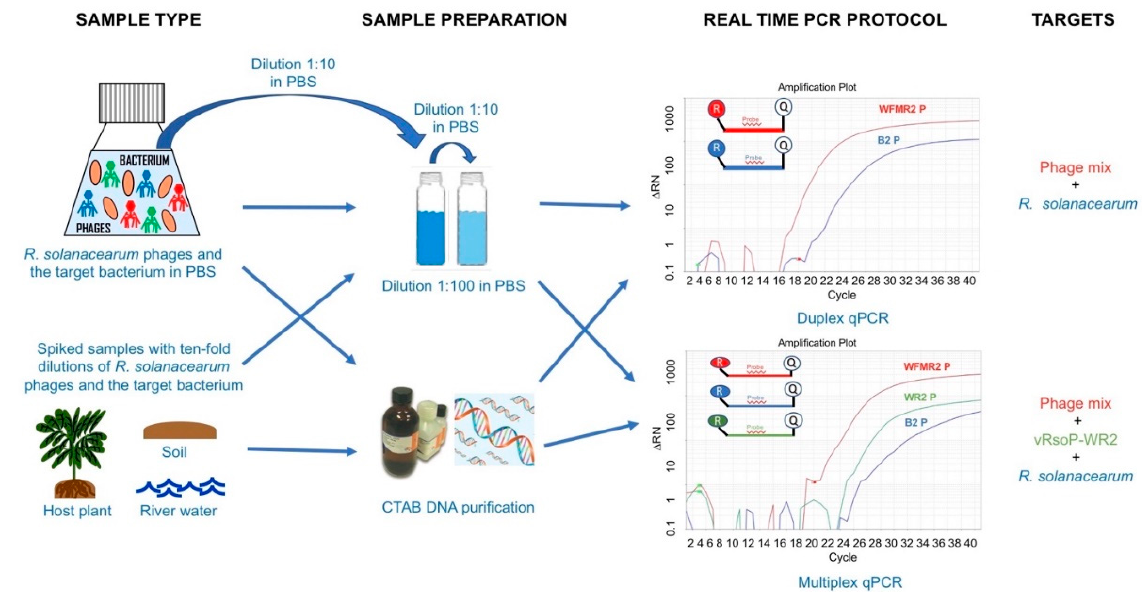
Figure 1. Graphical summary of the methodology developed for the detection and quanti fi cation of the Ralstonia solanacea- rum phages vRsoP-WF2, vRsoP-WM2, and vRsoP-WR2, and the target bacterium in environmental water, soil, and plant material using duplex and multiplex qPCR.